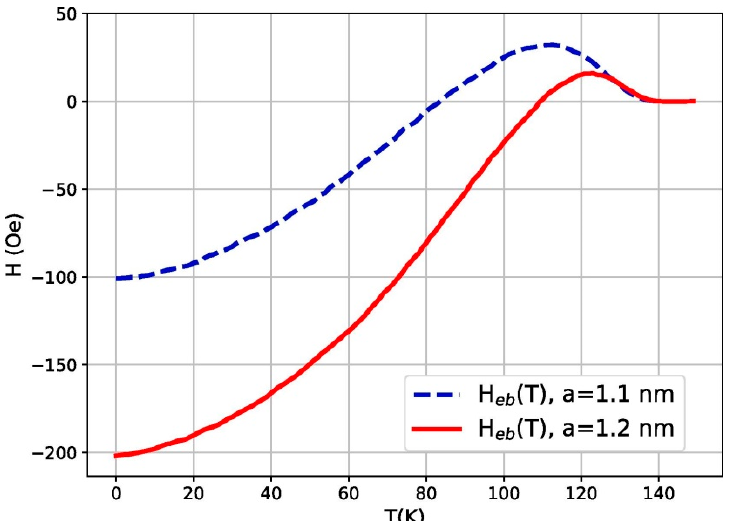
Figure 8. Temperature-dependent exchange bias, modeled for slightly different grain sizes. Reprinted with permission from [88], Copyright 2021 Elsevier.